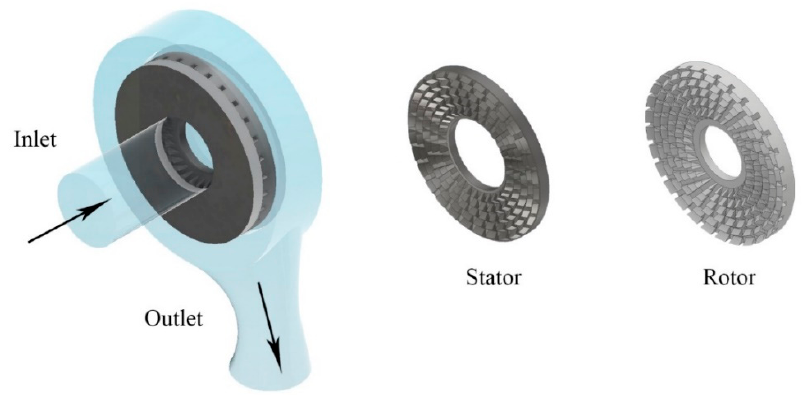
Figure 2. Model of the rotor-stator mixer.